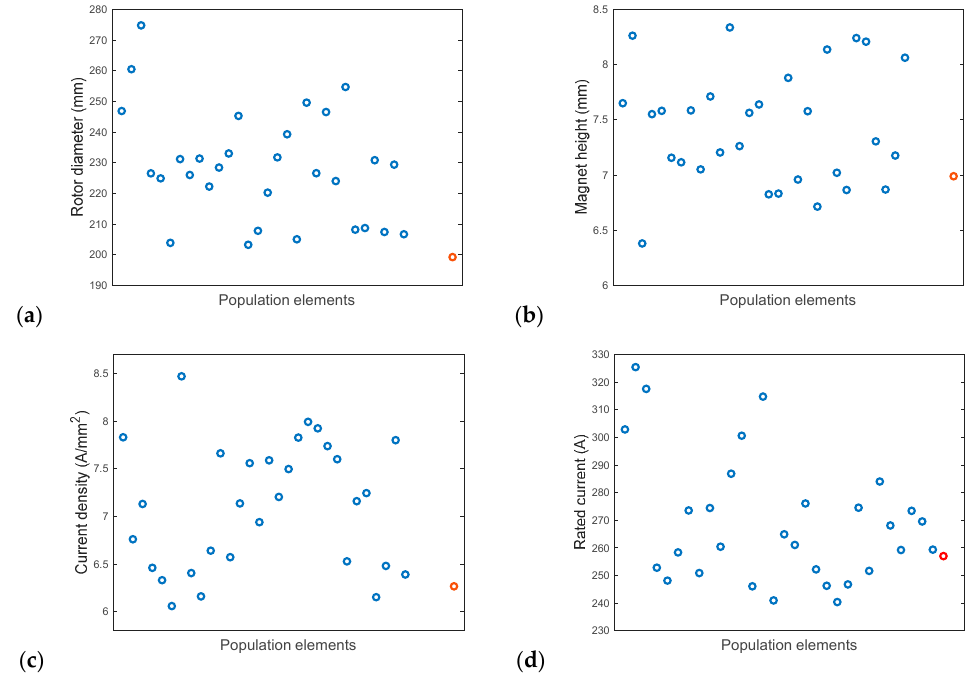
Figure 6. Initial population distribution (blue circles), optimal solution (red circle): ( a ) Rotor external diameter (mm); ( b ) current density (A/mm 2 ); ( c ) magnet height (mm); ( d ) rated current (A).